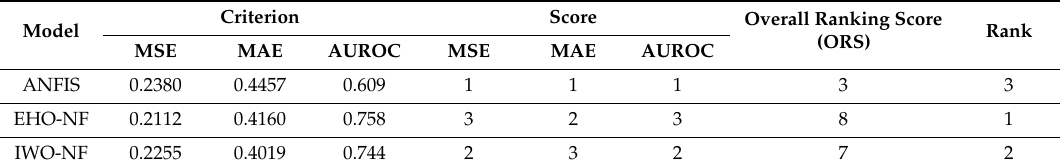
Table 4. The obtained accuracy criteria for the used models.